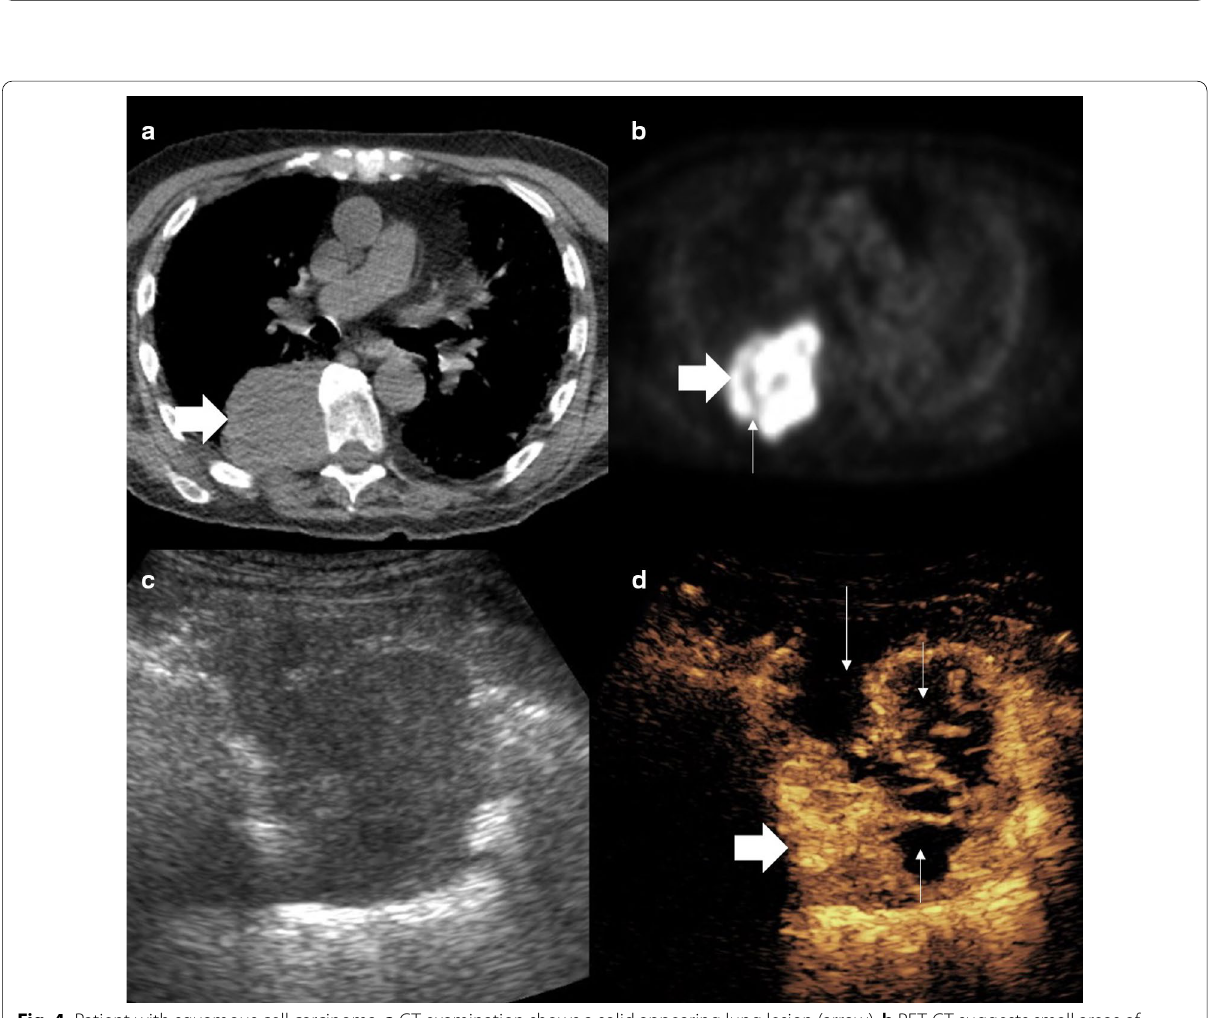
Fig. 4 Patient with squamous cell carcinoma. a CT examination shows a solid appearing lung lesion (arrow). b PET‑CT suggests small areas of necrosis (thin arrow) within the avid lesion (arrow). c , d Simultaneous B mode and CEUS images show the hyperenhancing lesion (arrow) with better appreciation of the complexity and volume of necrosis (thin arrows) indicating a deep eccentric portion required targeting for biopsy